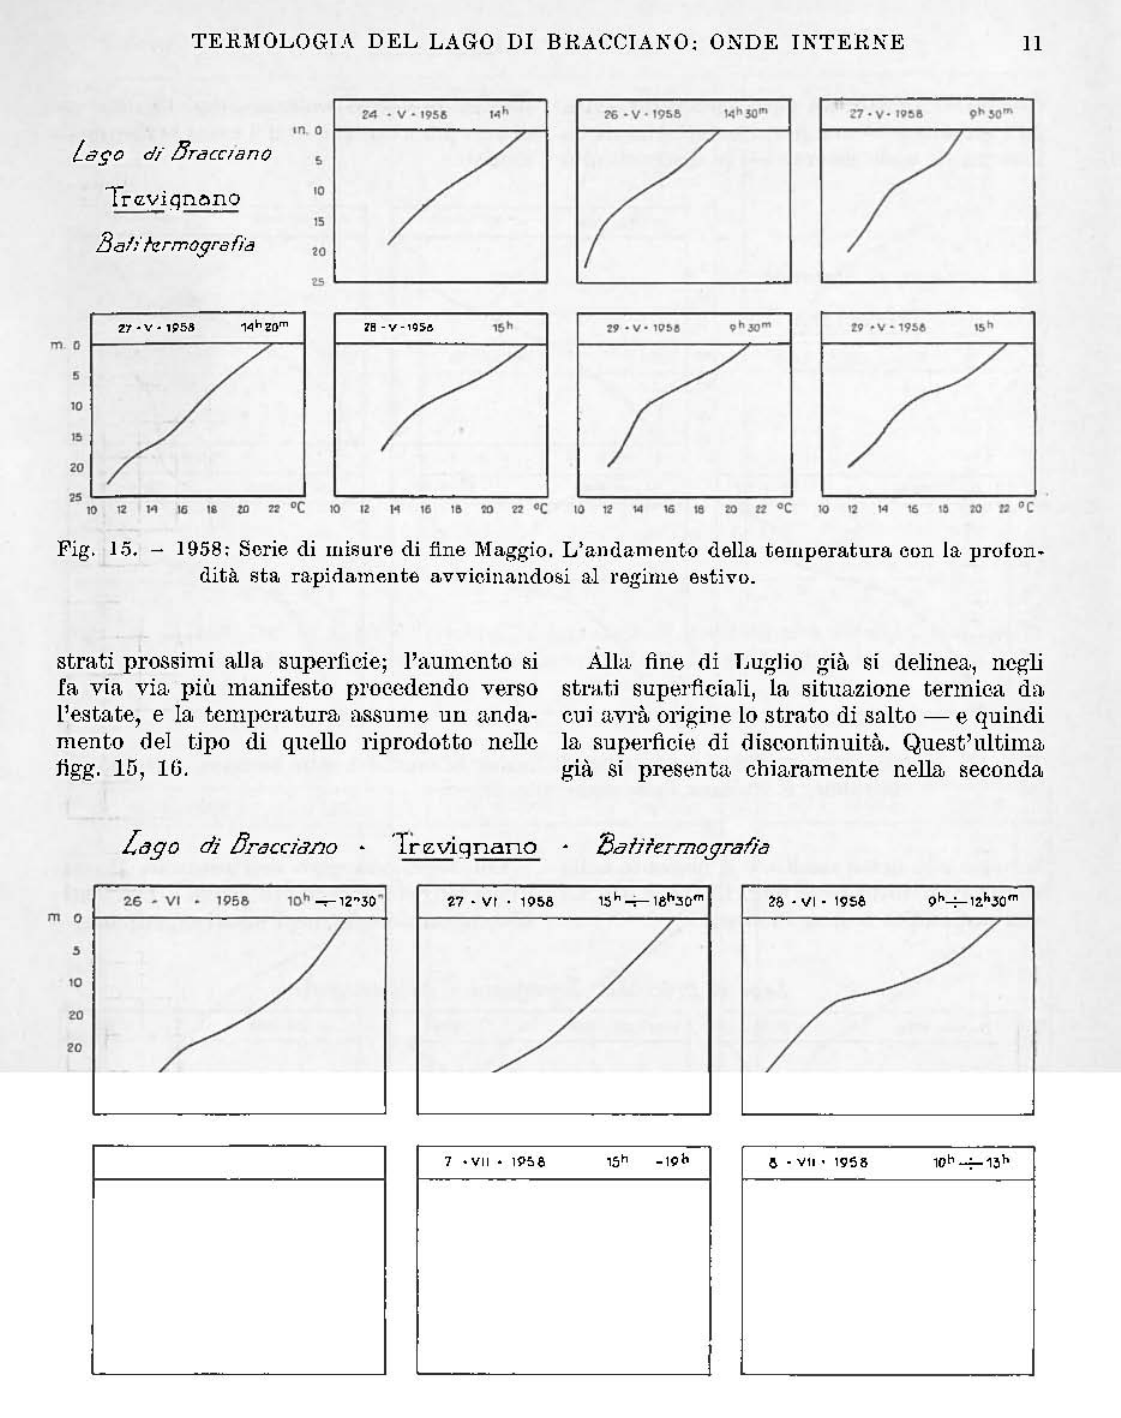
l<'ig. 16. - 1958: Serie di mi8ure fine Giugno-principio Luglio. La. zona del salto termico è già virtualmente formata. anr,lle 8e ancora instabile e. comunque, alterata. dalle onde